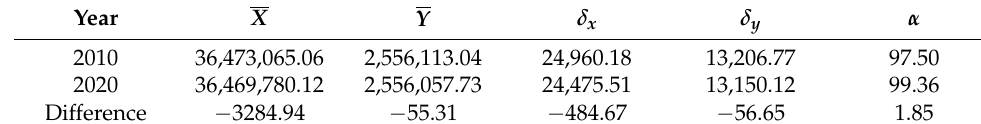
Table 4. Variations of SDE parameters.